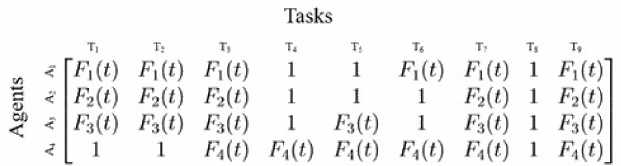
Figure 24. Failure Matrix (FM) of the example MAS.